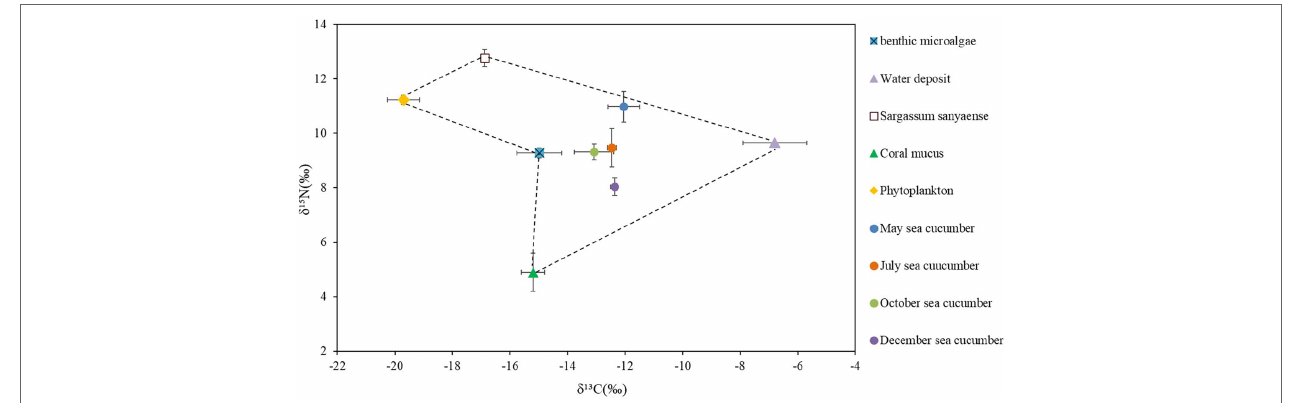
FIGURE 6 | Dual stable isotope plots of δ 13 C and δ 15 N for the sea cucumber Stichopus monotuberculatus and its potential food sources in two sampling seasons, from May to December 2019. The stable isotope ratios of sea cucumber were corrected with the average fractionation effects of 1.0‰ and 3.4‰ for C and N, respectively. Note: the values of δ 13 C and δ 15 N for coral mucus are −16.2 ± 0.4 and 1.5 ± 0.7 ( Naumann et al., 2010